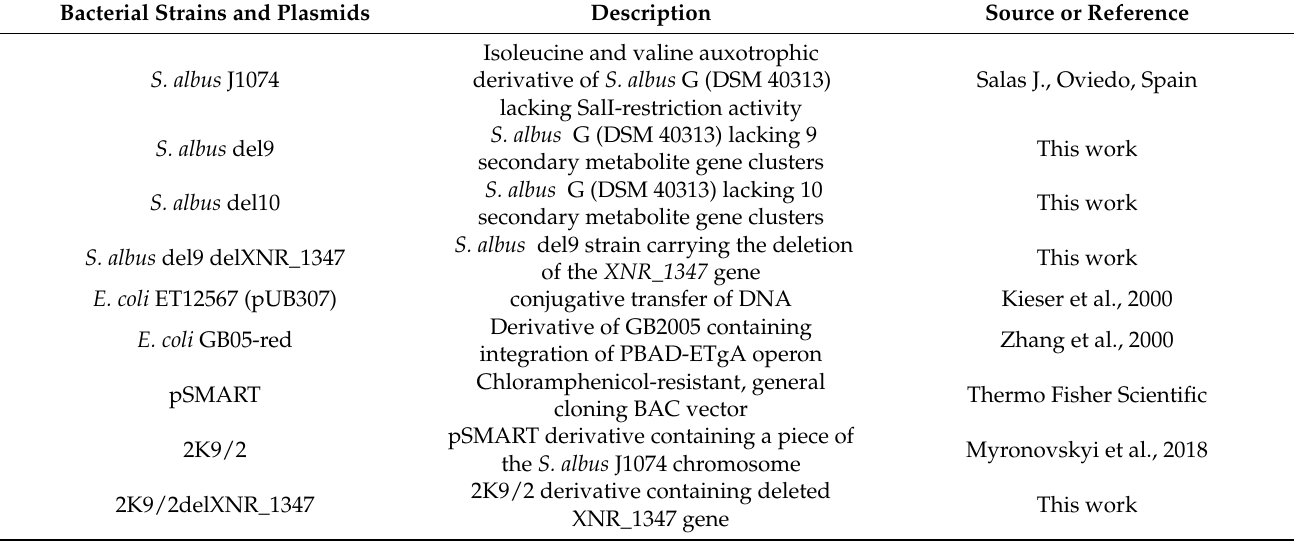
Table 1. Strains and plasmids used in this study.